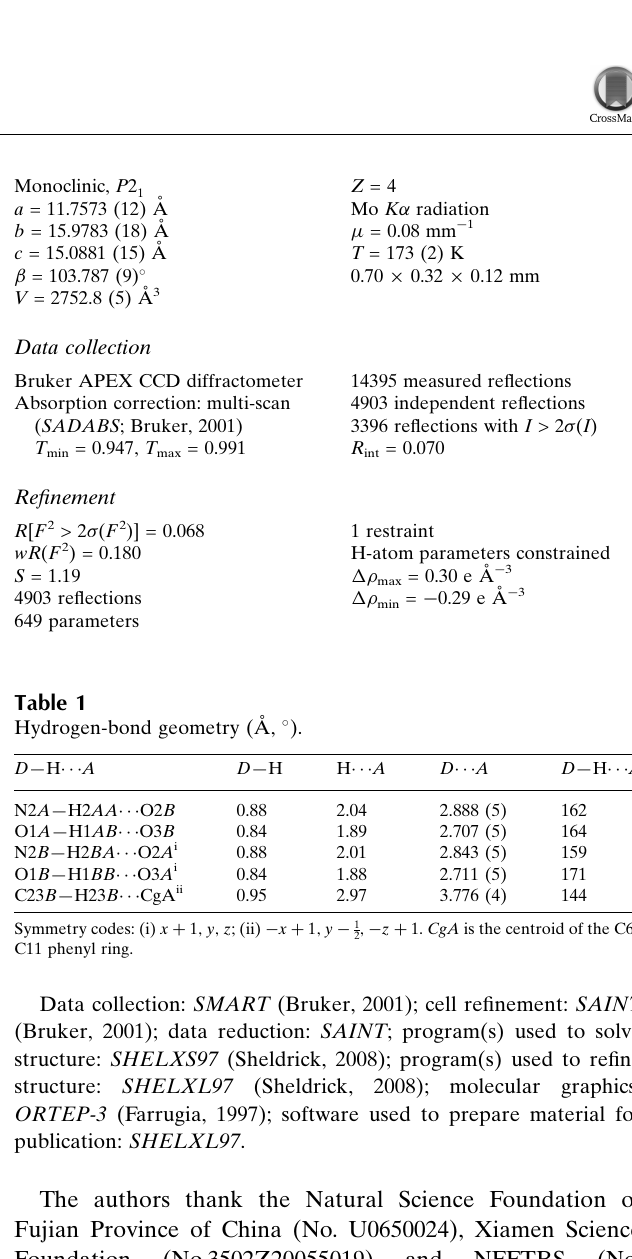
Related literature